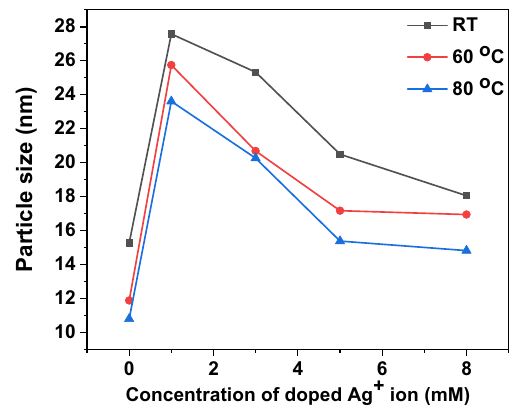
Figure 6. Variation of particles size for the pure ZnO and Ag–ZnO with different concentrations of Ag at different synthesis temperatures.